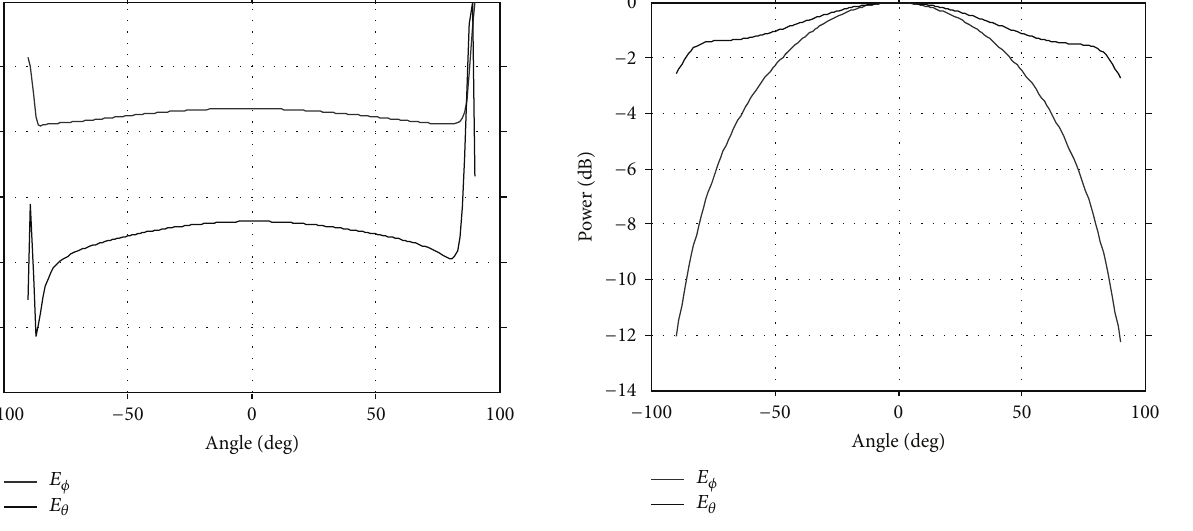
Figure 11: Near field radiation pattern of circular waveguide at 𝑟 = 0.2𝜆 (0.64cm).